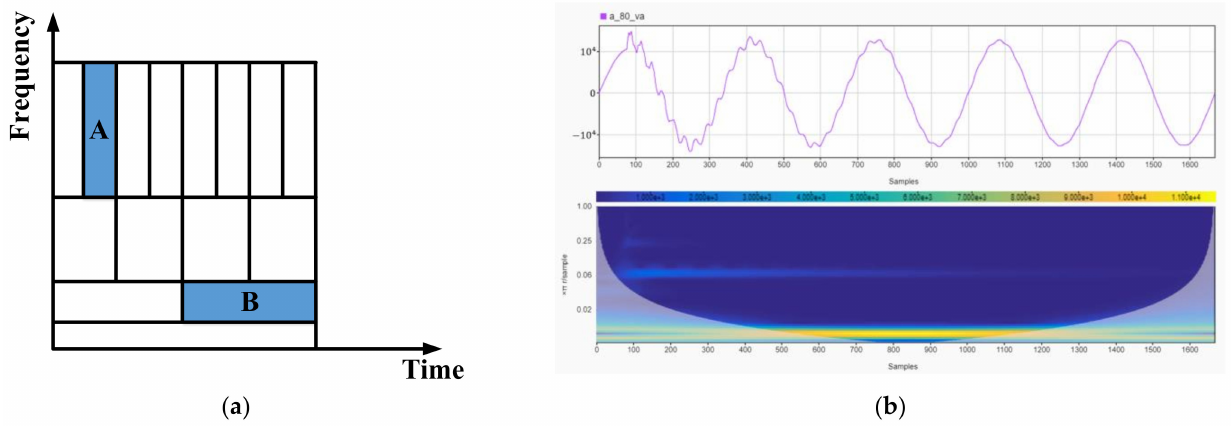
Figure 5. Wavelet transform. ( a ) Wavelet transform concept diagram. ( b ) Open conductor fault voltage measured in a MATLAB